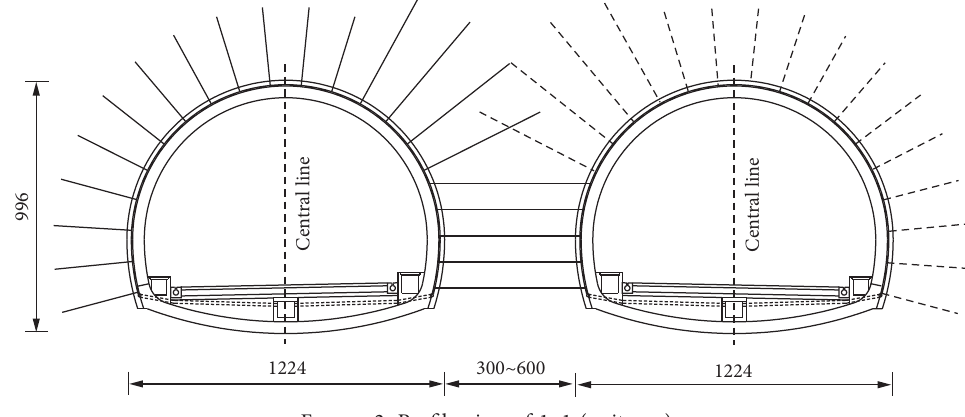
Figure 2: Profile view of 1–1 (unit: cm).